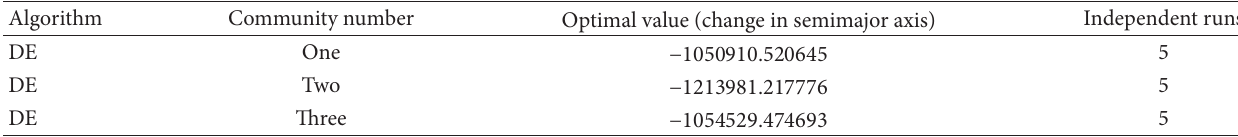
Table 13: Optimal value of each community.